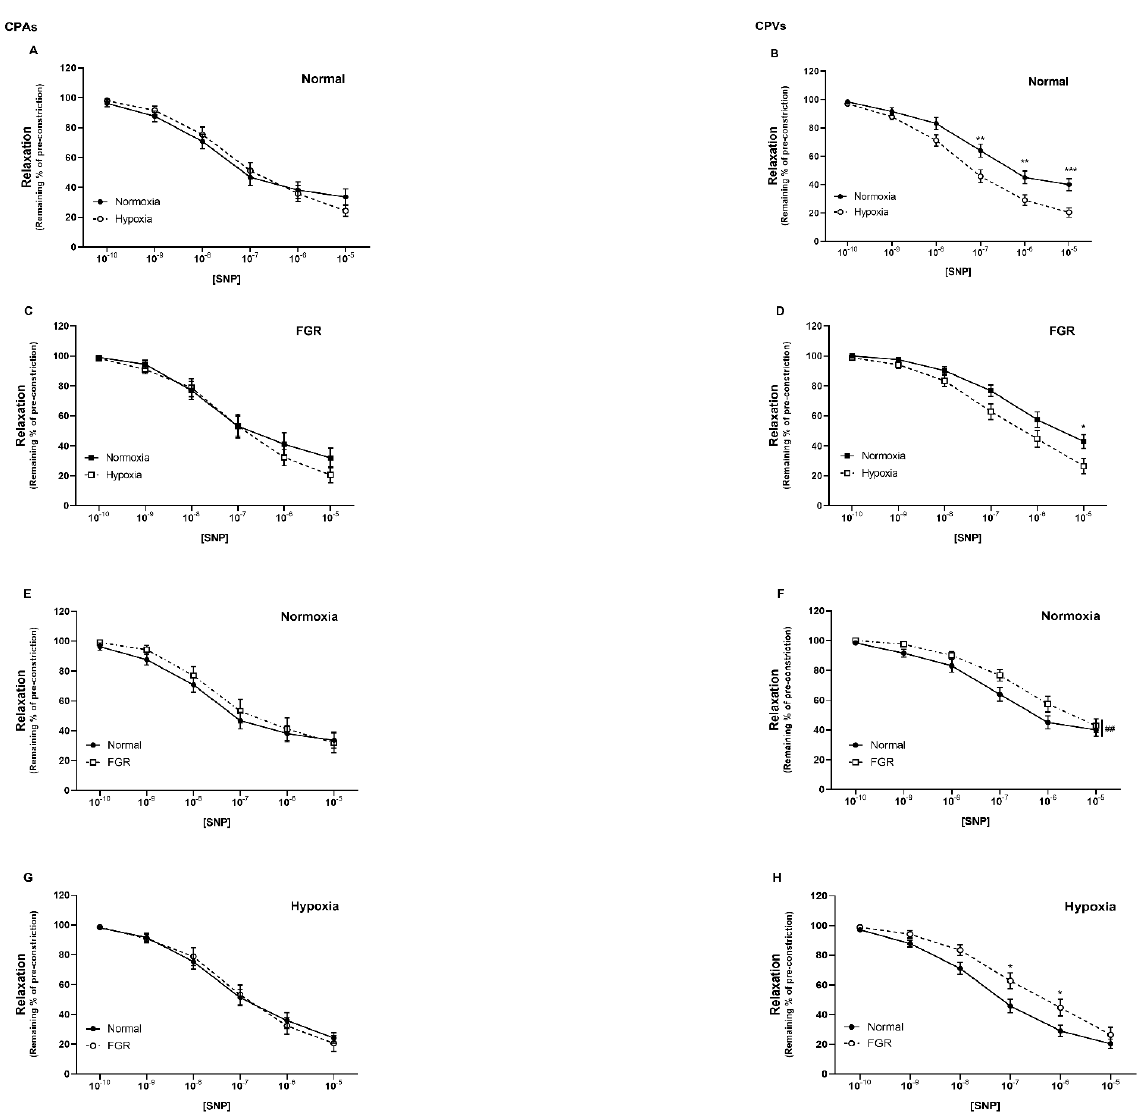
Figure 2. Sodium nitroprusside − mediated relaxation is enhanced by hypoxia in human chorionic plate veins from both normal and FGR pregnancies. Concentration − dependent vasorelaxant effect of SNP on: normal CPAs ( A ) and CPVs ( B ), FGR CPAs ( C ) and CPVs ( D ), in normoxia and hypoxia; normoxic CPAs ( E ) and CPVs ( F ), hypoxic CPAs ( G ) and CPVs ( H ), from normal and FGR pregnancies. * p < 0.05, ** p < 0.01, *** p < 0.001, normoxia vs. hypoxia; ## p < 0.01, normal vs. FGR. n = 14–30 placentas per